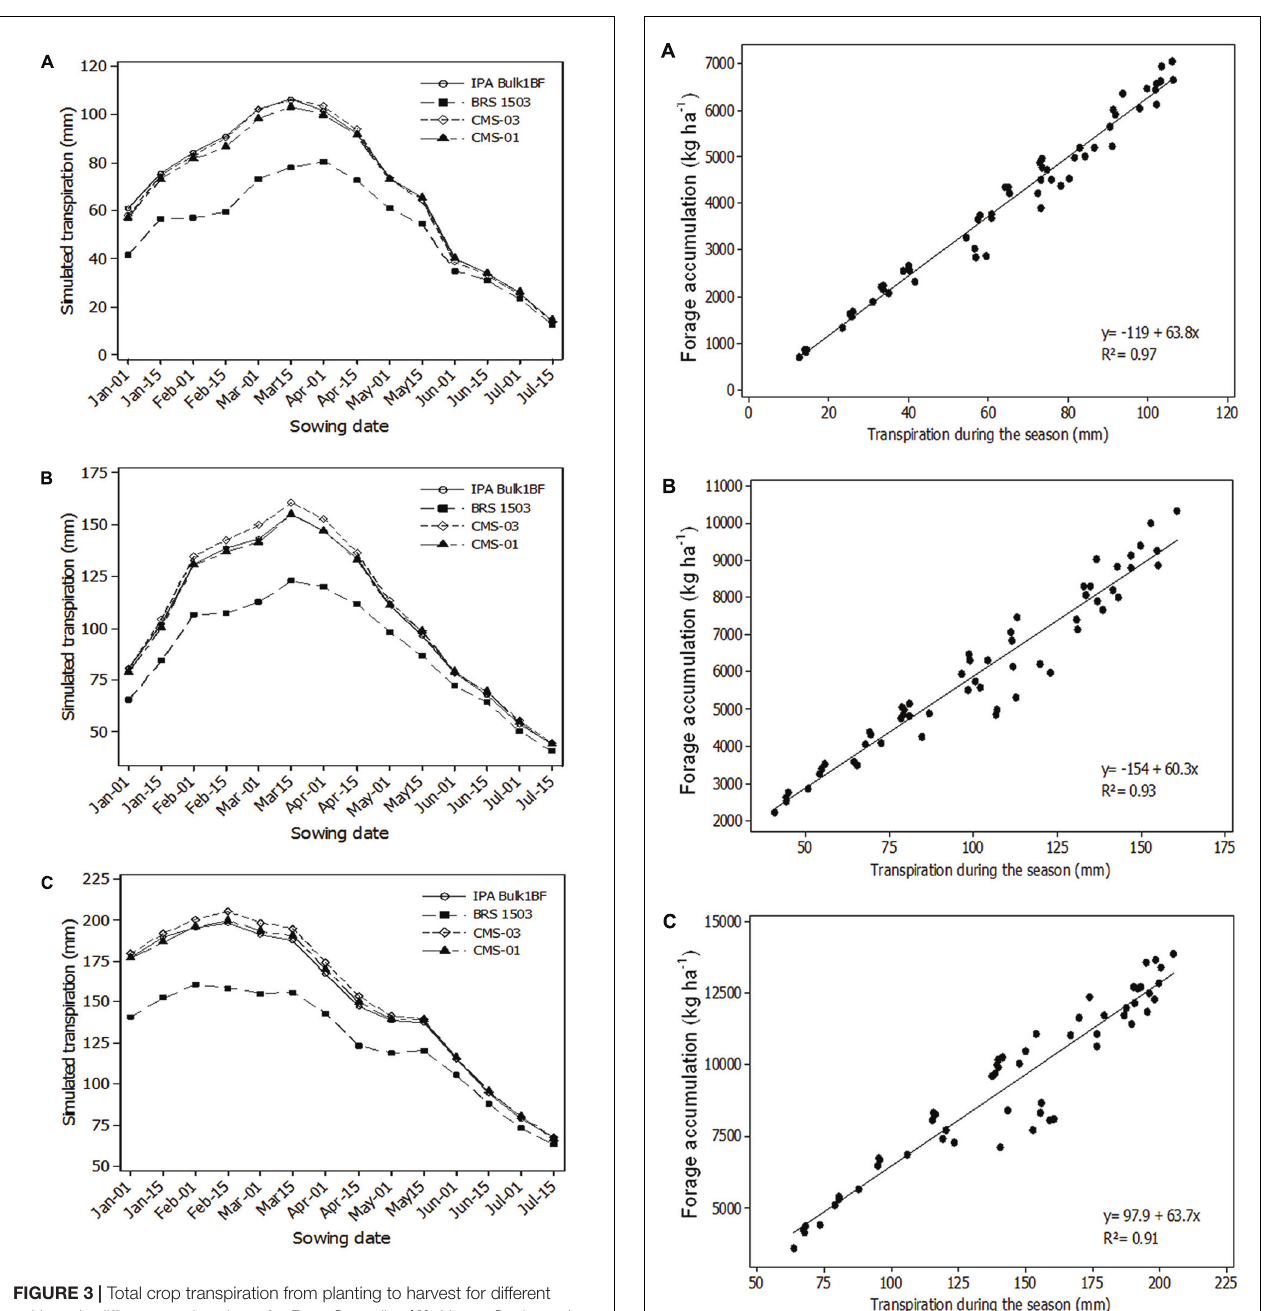
FIGURE 3 | Total crop transpiration from planting to harvest for different cultivars in different sowing dates for Bom Conselho (A) , Nossa Senhora da Gloria (B) , and Sao Bento do Una (C) .